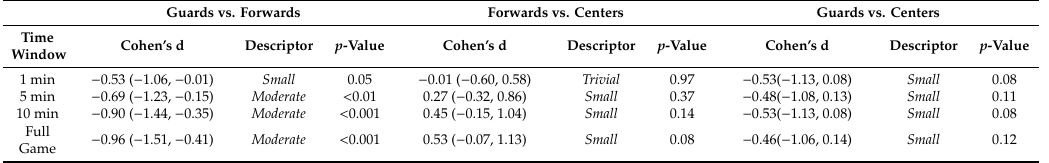
Table 3. E ff ect sizes (Cohen’s d with 95% confidence intervals) for pairwise comparisons between guards, forwards, and centers for player load in male U18 basketball players. Guardsvs. Forwards Forwardsvs. Centers Guardsvs. Centers